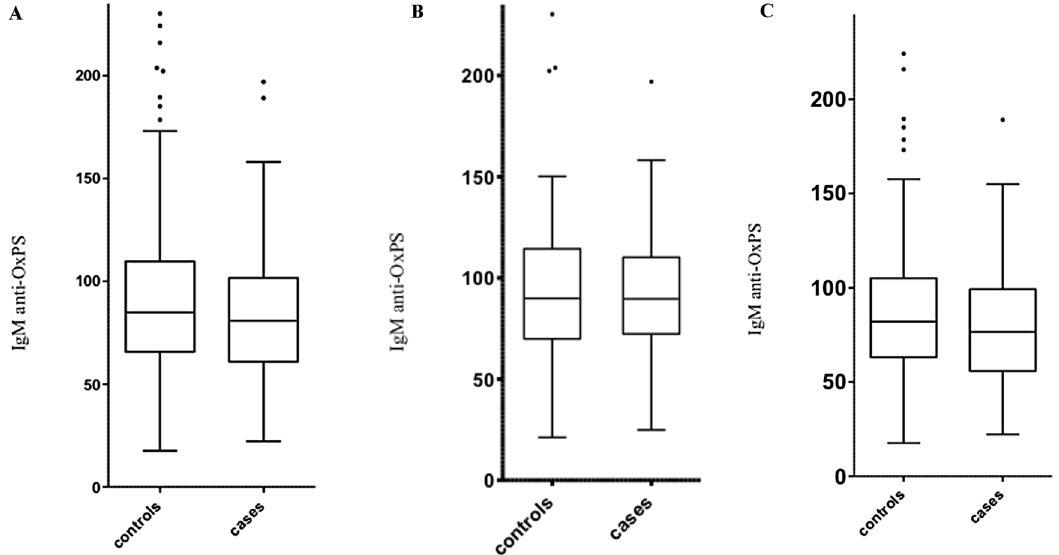
Fig 1. a. Distribution of IgM anti-OxPS among cases and controls . 0 = controls who did not developCVD duringthe follow up time, 1 = controls who did developCVD. Cases hade significantly lower levels than controls (p =